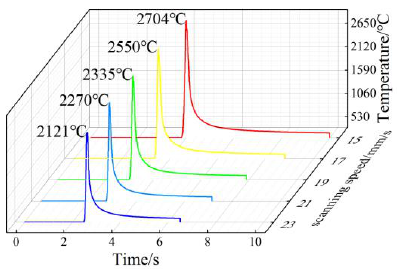
Figure 6. Variation of molten pool temperature under different scanning speeds. Comparison of experimental and simulation results, the effect of scanning speed on the size of the molten pool is shown in Figure 7.